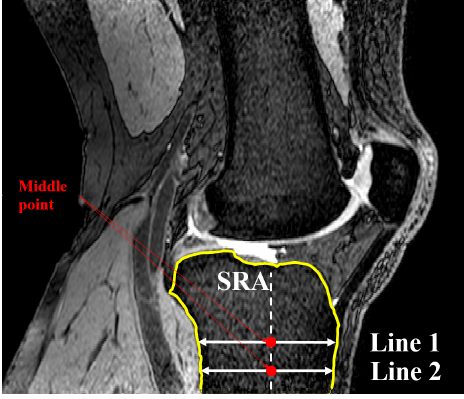
Figure 3. Drawing line 2 in the SRS to define SRA (sagittal view).